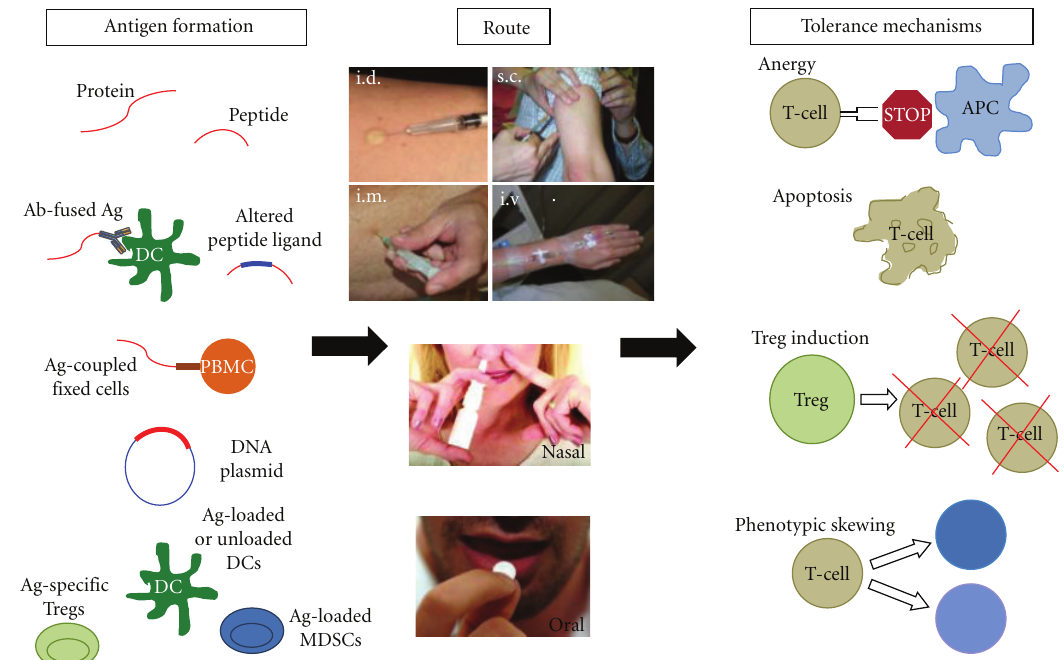
Figure 2: Ag-specific immune therapies. Di ff erent Ag formulations can be administered via di ff erent routes, triggering various tolerance mechanisms. APC: Ag-presenting cell; DC: dendritic cell; i.d.: intradermal; i.m., intramuscular; i.v.: intravenous; MDSCs: myeloid-derived suppressor cells; PBMC: peripheral blood mononuclear cell; s.c.: subcutaneous; Tregs: regulatory T